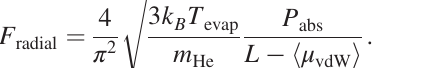
FIG. 1. (a) In bulk, a local heat source generates flow of superfluid helium (blue arrows) and counterflow of normal fluid (red arrow), imparting momentum onto the oscillator. (b) Repre- sentation of a microtoroid covered in a thin film of superfluid helium. Heat around the periphery caused by optical absorption generates fluid flow (blue arrows). At low pressures the super- fluid then transitions directly into the gas phase and imparts momentum on evaporation (red arrows). (c) Superfluid-mediated photoconvective forcing may be readily extended to other optomechanical systems such as photonic-phononic crystal cavities, membranes, and nanostrings. Evaporation of a thin film from a photonic-phononic crystal cavity (left) due to localized optical heating would actuate the mechanical breathing modes commonly used in quantum optomechanics experiments. A mechanical membrane (middle) could be driven by bulk flow if one half was immersed in bulk superfluid helium via the mechanism of (a). The string modes of a nanostring (right) could be actuated by coating its top surface with an absorbing material upon which light is focused. This would cause preferential vertical evaporation of a thin superfluid film self-assembled on the